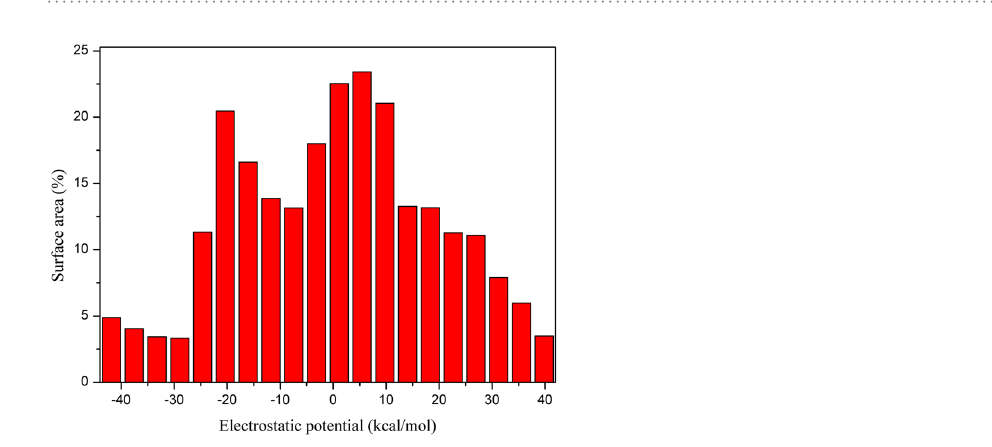
quantificationally calculated. The ESP values ranged from − 20 Kcal/mol to 20 Kcal/mol widely distribute on the surface area. Thereinto, the negative ESP values mainly origin from the π -electron cloud of aromatic nucleus, the aromatic nucleus of C-H hydrogens mainly contribute to the positive areas. In the Fig. 11, the highest occupied molecular orbital (HOMO) and the lowest unoccupied molecular orbital (LUMO) have been revealed. Upon the photo-induced process, the electron distribution mainly changes from the π character on the HOMO to the π * character on the LUMO. Herein, we only analyze the HOMO and LUMO, because transient excitation mainly stems from the contribution of HOMO → LUMO transition. The transition contribution of ππ * character and corresponding oscillator strength have been listed in the Table 5. In this table, Oscillator strength (f) of ik-HPIP and v-HPIP is 0.1334 and 0.0026, respectively. Their fluorescence compared with the fluorescence of cis-HPIP has been quenched. In the Fig. 11(a), electron redistribution in the PCM is nearly identical to that in the mixed solva- tion. For further studying the relationship between torsion of molecule structure and electron redistribution, we have obtained non-coplanar HPIP (np-HPIP) form by factitiously twisting the dihedral angle δ (N 2 -C 3 C 8 -C 9 ) in the theoretical calculation, in which the np-HPIP molecule cannot be obtained actually in the S 0 state. The MOs graphs of np-HPIP form have been shown in the Fig. 11(b). Its electron redistribution of the HOMO → LUMO compared with that of cis-HPIP still is not significant change. Therefore, we draw a conclusion that factitious torsion of molecule structure cannot result in the drastic electron redistribution on the np-HPIP. However, the HOMO and LUMO of the ik-HPIP, v-HPIP and trans-k-HPIP have been depicted in the Fig. 11(c,d) and (e). The electron redistribution of these isomeric forms is great different from that of cis-HPIP. It should be noted that electron population of the isomeric forms is unbalanced for HOMO → LUMO. These isomeric forms are zwitterions that the imino group carries positive electric charges and the ketonic oxygen atom carries negative electric charges. ICT character of these zwitterions can lead to the increasing of the dipole moments in the S 1 state, so the corresponding electron population will be unbalanced in the molecule. Moreover, the unbalanced electron population can further result in the torsion of isomeric forms. It is worth noting that TICT character of